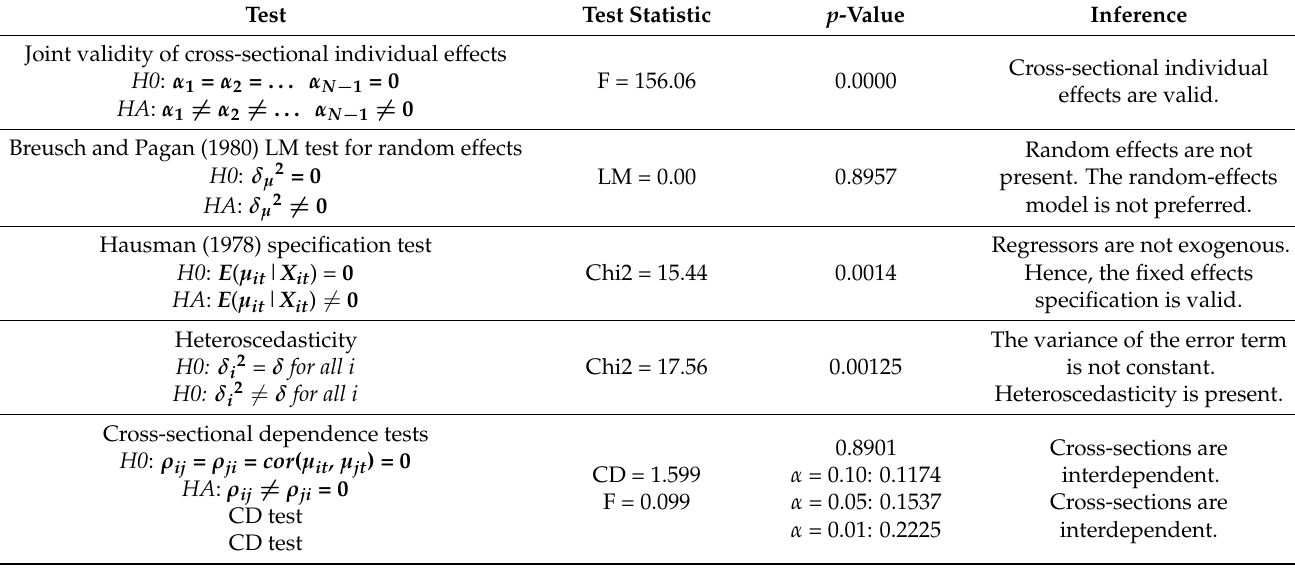
Table A1. Diagnostic tests with insurance penetration employed as the dependent